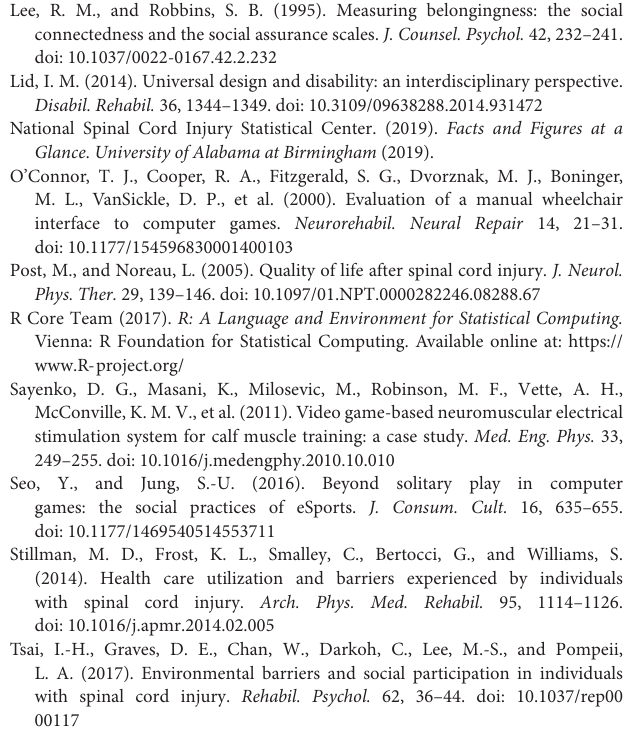
representations of the gaming console in use. Column C holds the controls of the QuadStick that are mapped onto the button representations of the gaming console. Column B holds any special formulas for mapping the buttons—none are in place in this example. Column D holds an explanation of the function of each control. This spreadsheet is created in google sheets and loaded into the QuadStick through a USB connection using the QuadStick Manager Program (QMP). The Quadstick is then connected to the gaming console of choice through a USB or bluetooth